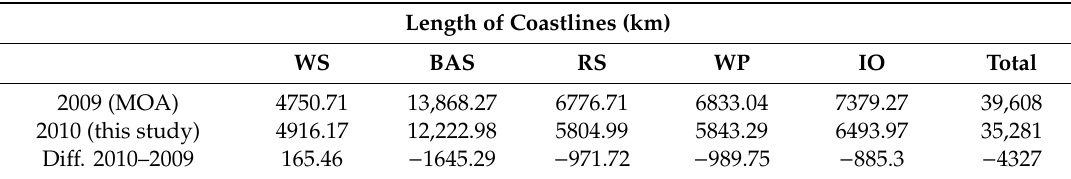
Table 3. Coastline length in each sector (km) in 2009 (MOA) and 2010 (this study). WS, Weddell Sea; BAS, Bellingshausen Amundsen Seas; RS, Ross Sea; WP, West Pacific; and IO, Indian